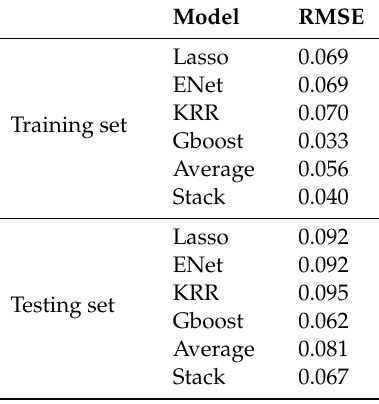
Table 6. RMSE of ML